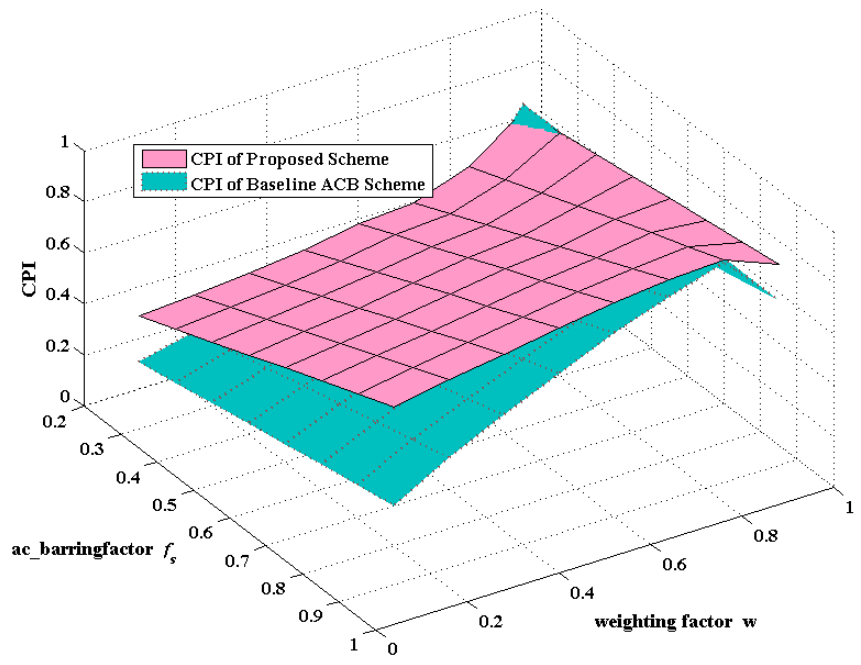
Figure 9. The comprehensive parameter index (CPI) varies with the synchronous change of ω and f s between the proposed scheme and the baseline ACB